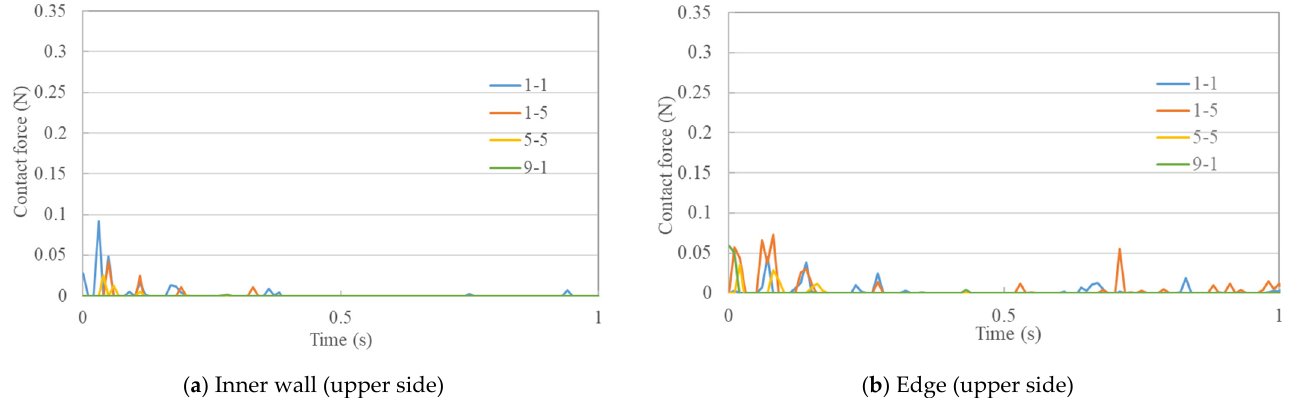
Figure 19. ( a , b ) Time history of contact force inside inlet and at tip of inlet just before application of second tension.